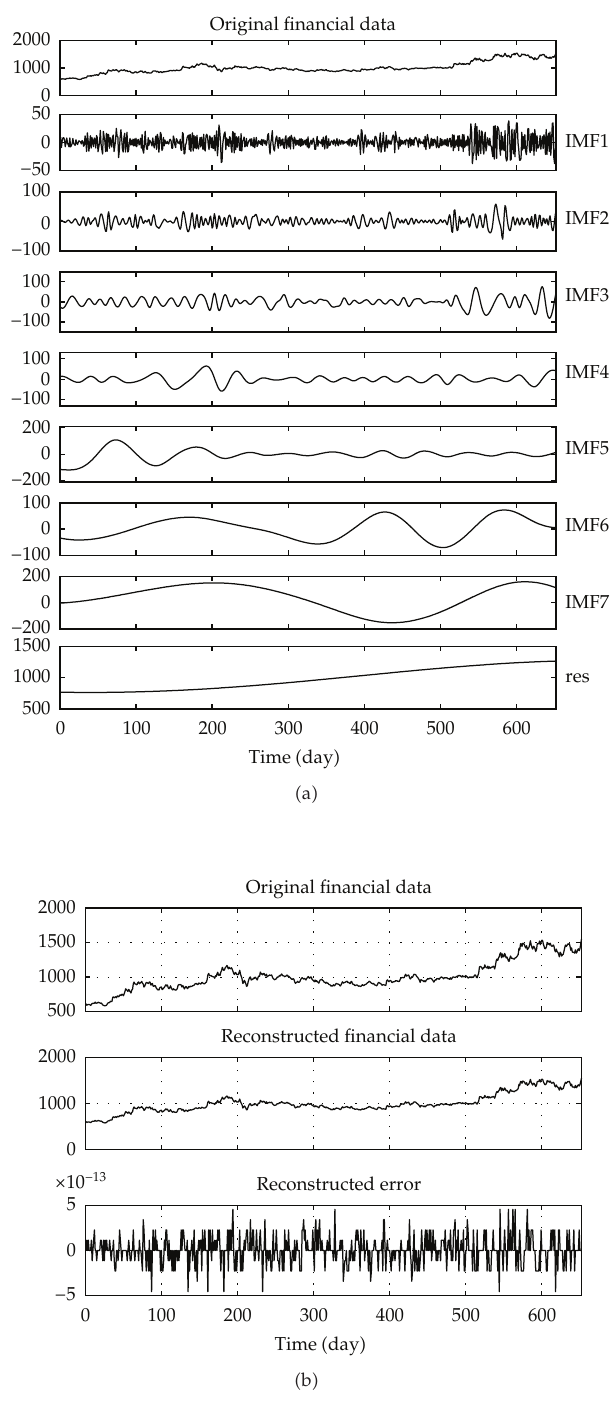
Figure 3: (cid:2) a (cid:3) EMD (cid:2) di ff erent IMFs (cid:3) of financial data. (cid:2) b (cid:3) Original financial data for channel 1 (cid:2) top (cid:3) , reconstructed data by simply adding the IMFs (cid:2) middle (cid:3) , and reconstruction error (cid:2) bottom (cid:3) . The SNR of the reconstructed signal is